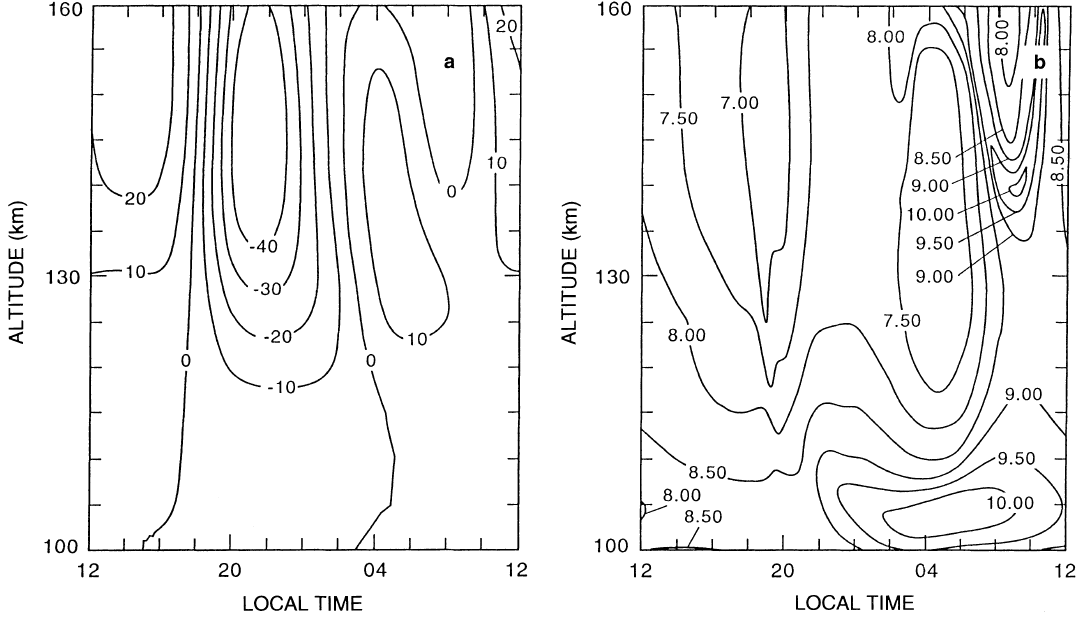
Fig. 10.a Height versus latitude contours of vertical ion drift at 9 (cid:176) latitude due to zonal and meridional winds and electric field. b The corresponding contours of log